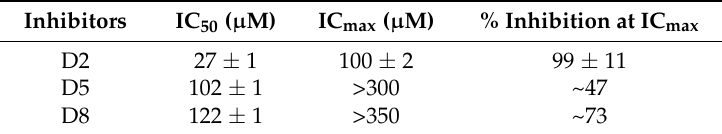
Table 3. Effect of Xcc FPR inhibitors on the NADPH-dependent DCPIP diaphorase activity of An FNR. Kinetic measurements carried out at 25 ◦ C, in 50 mM Tris/HCl, 2% DMSO, pH 8.0, using 4 nM An FNR, with saturating DCPIP (95 µ M) and NADPH (50 µ M), and varying the concentration of the compounds in the 0–800 µ M range ( n = 3, means ± SD). IC 50 and IC max stand for the concentration of the compound causing 50% enzyme inhibition and maximal inhibition, respectively. Inhibitors IC 50 ( µ M) IC max ( µ M)